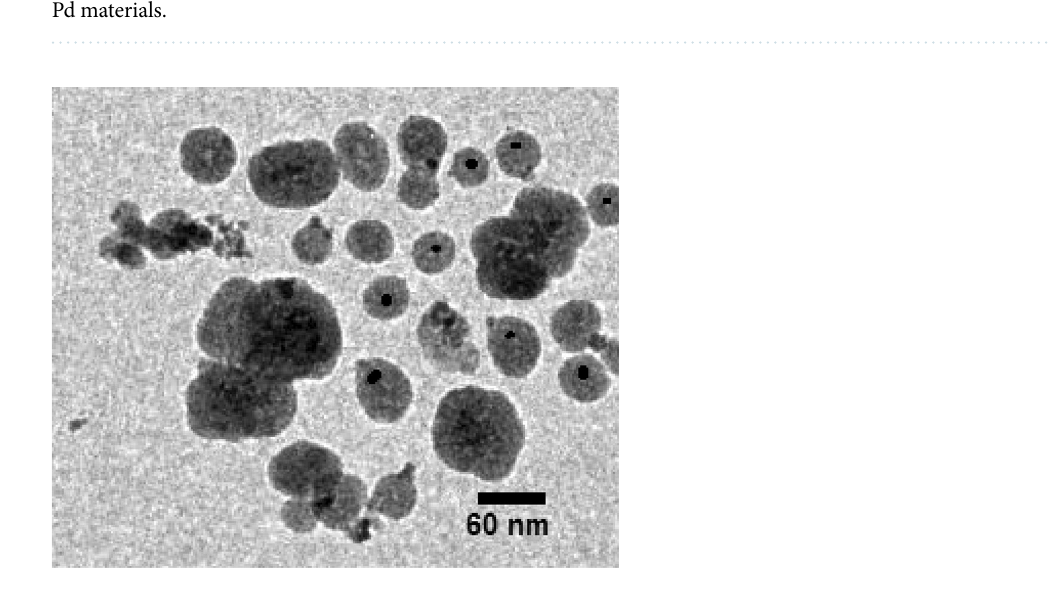
Figure 9. TEM image of Fe 3 O 4 @SiO 2